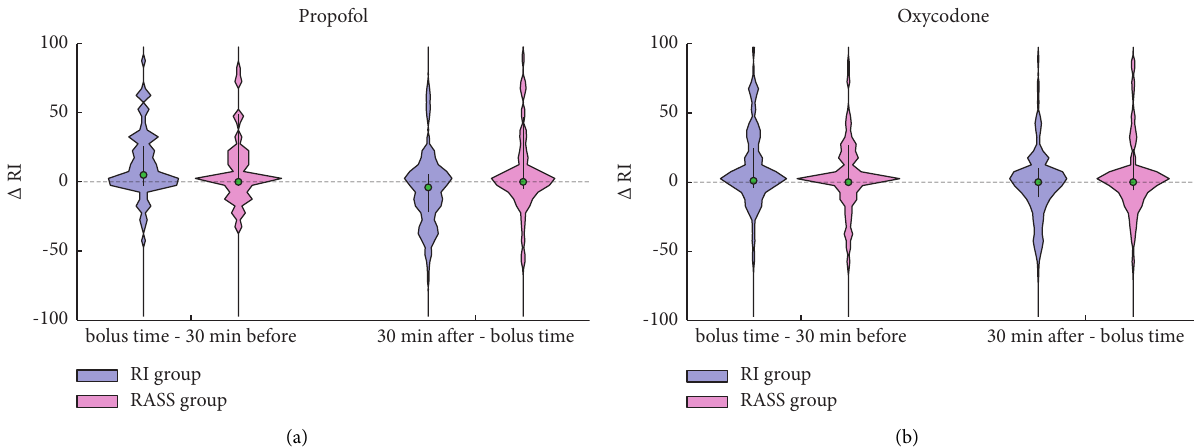
Figure 4: (a) Violin plot presenting the RI value change from 30 minutes before propofol bolus administration to the time of bolus administration (left) and the RI value change from the time of bolus to 30 minutes after the bolus (right). (b) Violin plot presenting the RI value change from 30 minutes before oxycodone bolus administration to the time of its administration (left) and the RI value change from the time of bolus to 30 minutes after the bolus (right). Cyan presents the RI group and magenta the RASS group. The violin plots present rotated data distribution; i.e., the wider the area is, the more samples are in the range. The thick black line indicates interquartile range, and the green circle is the median. In the RI group, propofol boluses were mostly administered to increasing RI values, and the RI values decreased during the following 30 minutes in most